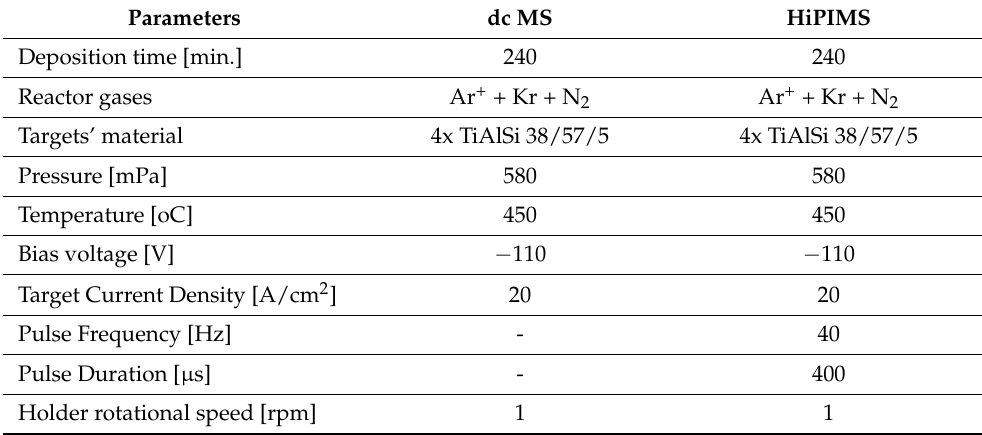
Table 1. Deposition parameters of the coatings obtained by dcMS and HiPIMS. Parameters dc MS HiPIMS Deposition time [min.] 240 240 Reactor gases Ar + + Kr + N 2 Targets’ material